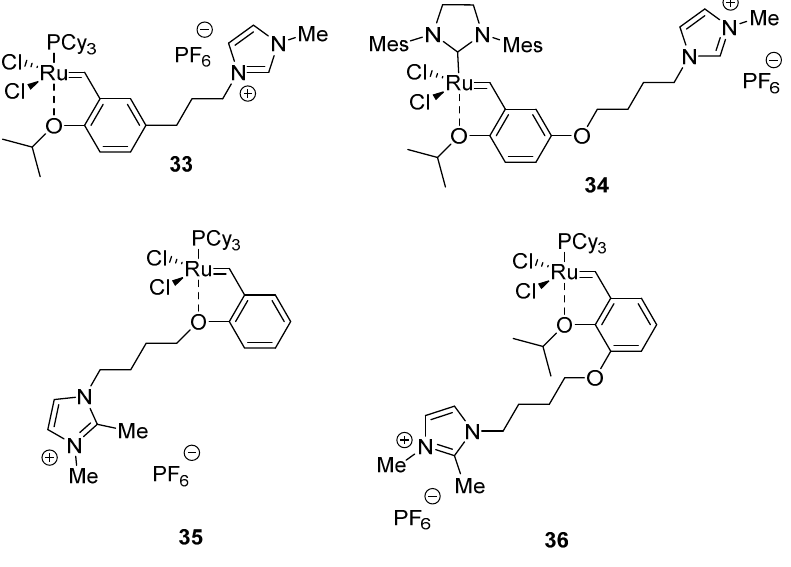
Figure 6. Ionic liquid-tagged ruthenium catalysts 33 – 36 .